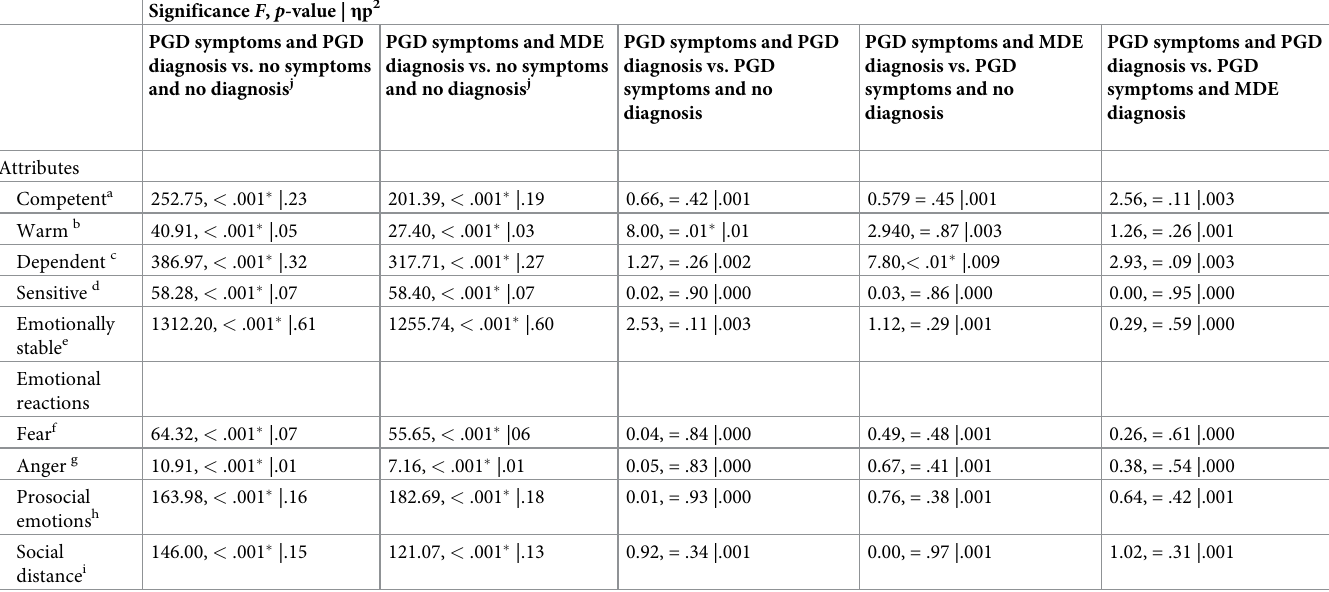
Table 4. Statistical results of the five planned contrasts for the stigma outcomes, i.e. attributes, emotional reactions and social distance.